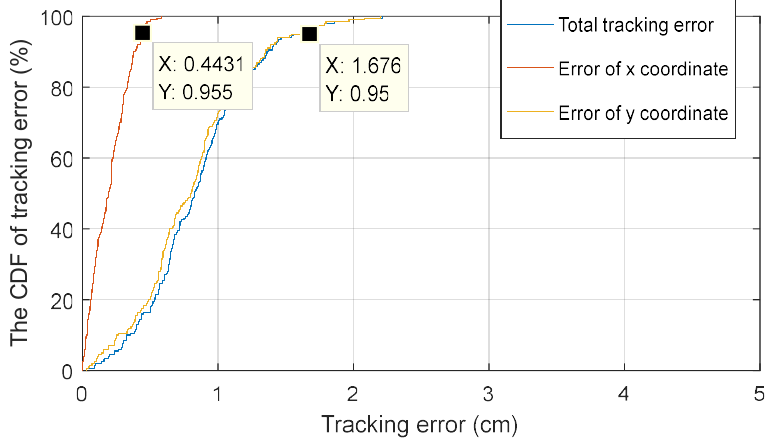
Figure 10. The cumulative distribution function (CDF) of the tracking error.